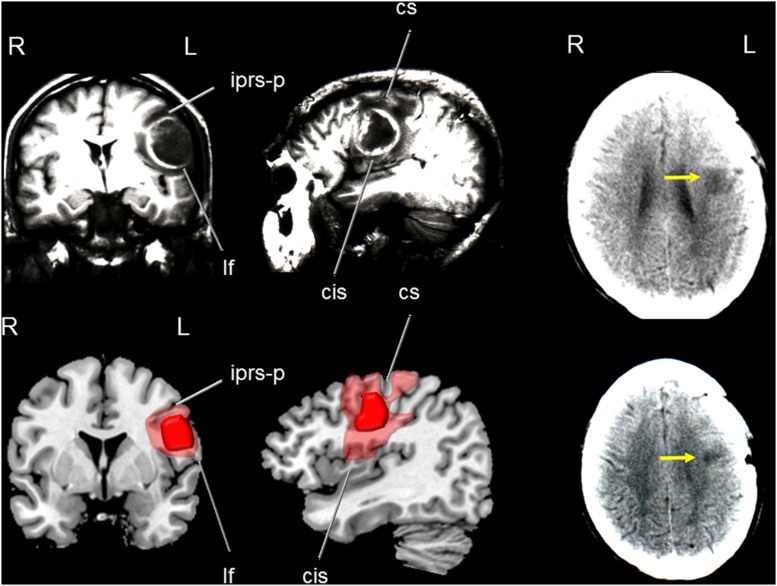
(Top) Coronal (left) and parasagittal (medial) T1-weighted MRI of patient JF showing a rounded, mature and encapsulated cerebral abscess involving the left sensory-motor cortex (medial part of the precentral gyrus) surrounded by vasogenic oedema. Note in the coronal view mass effect over the insula and basal ganglia. (Bottom) Drawings were made using MRIcro software (Rorden, C., 2005. www.mccauslandcenter.sc.edu/mricro/mricro/) on T1-weighted axial images. The abscess is drawn in red and areas of vasogenic oedema in light red. CT images performed 3 months after surgery (right images in the upper and lower panels) show a hypodense lesion in the left precentral gyrus. Fissures and sulcus are indicated with white arrows. iprs-p indicates: inferior precentral sulcus- posterior ramus; lf: lateral fissure; cs: central sulcus (sulcus of Rolando); and cis: central insular sulcus. Terminology and abbreviations for fissures and sulci were taken from the atlas of neuroanatomy of language regions of the human brain (Petrides, 2014). R: indicates right and L: left.